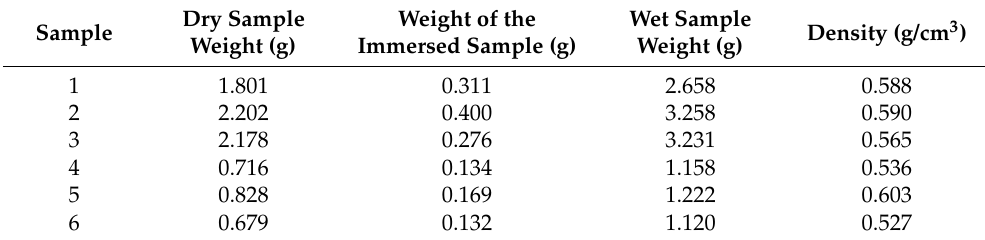
Table 2. Densities obtained by Archimedes’